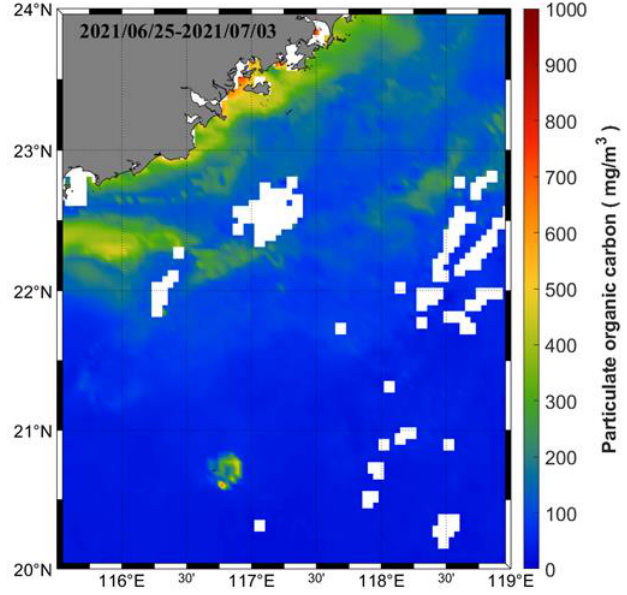
Figure 11. Examples of POC distribution derived from MODIS observations in the Chaoshan Sea.